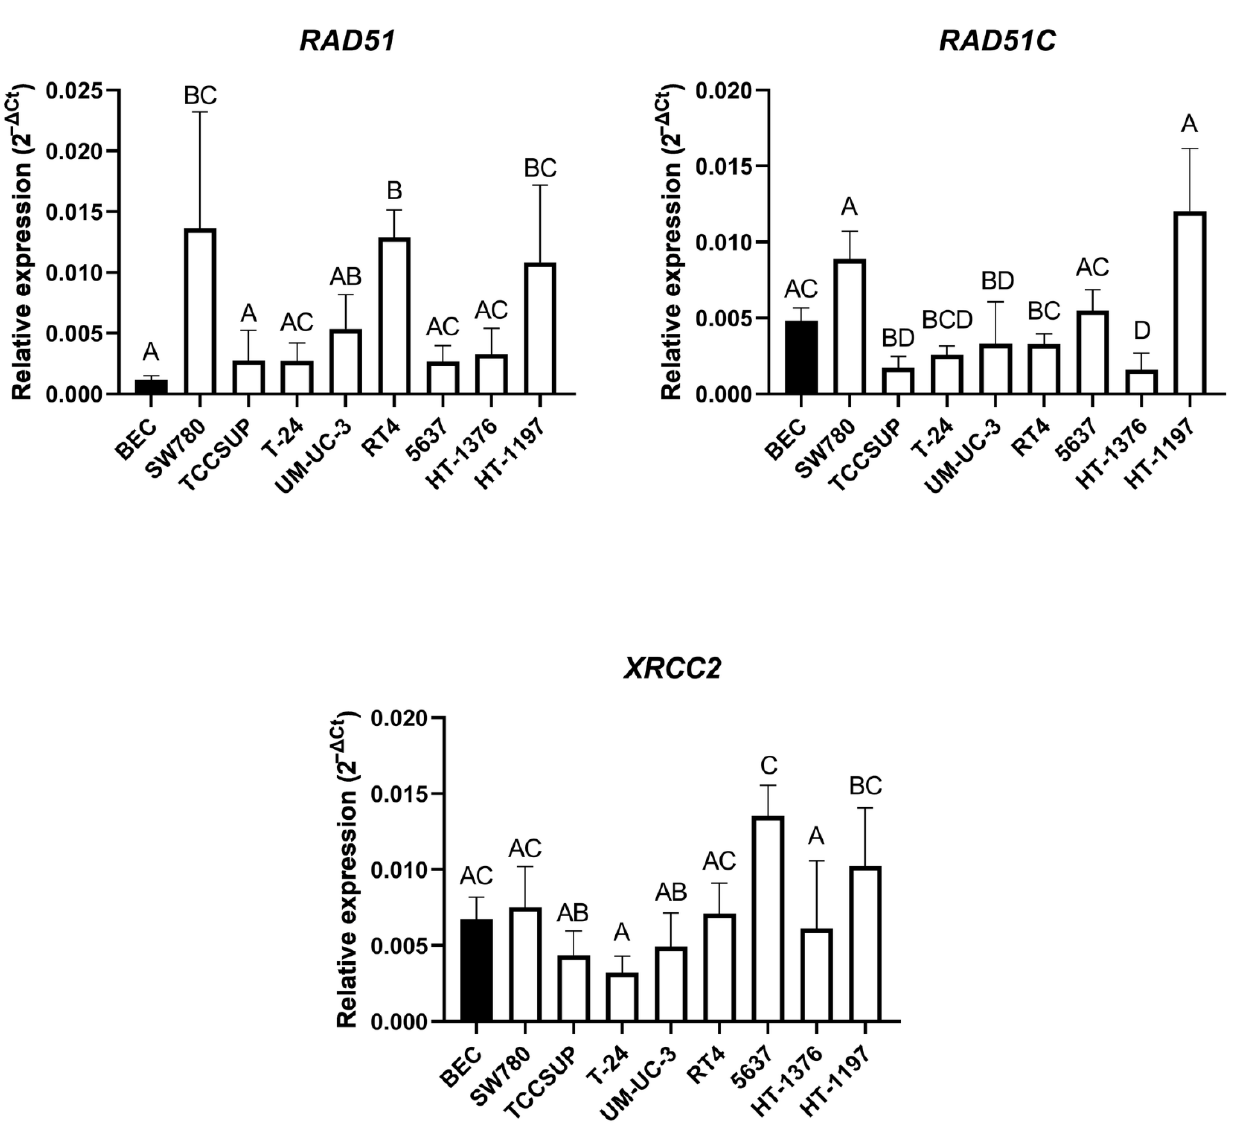
Figure 5. Relative basal gene expression of the selected HR factors in the UCC lines and BEC. Relative mRNA expression levels of RAD51 ( upper panel left ), RAD51C ( upper panel right ) and XRCC2 ( lower panel ). Values are reported as the mean with a 95% confidence interval from three biological and three technical replicates. Columns marked with the same letters did not show a statistically significant difference, while columns marked with different letters indicated a statistically significant difference using one-way ANOVA with Tukey post-hoc test for multiple